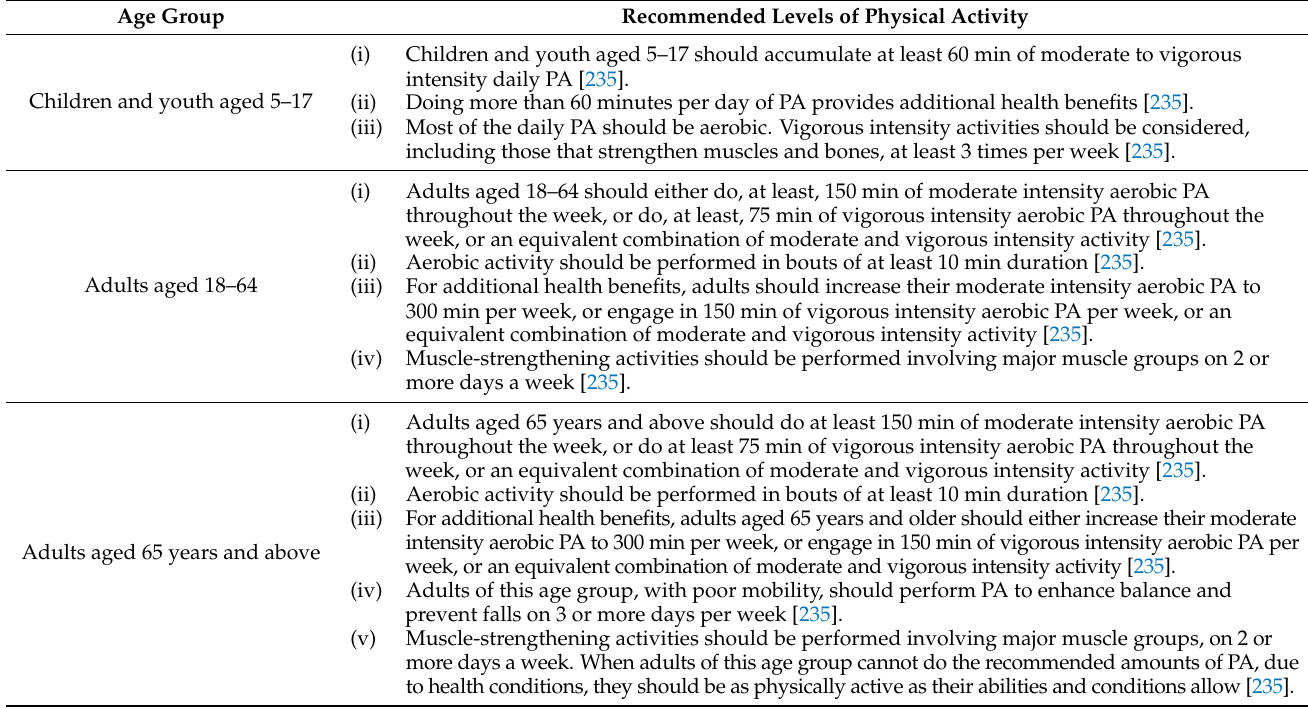
Table 4. WHO recommended levels of physical activity (PA) for three age groups: 5–17 years old, 18–64 years old and 65 years old and above